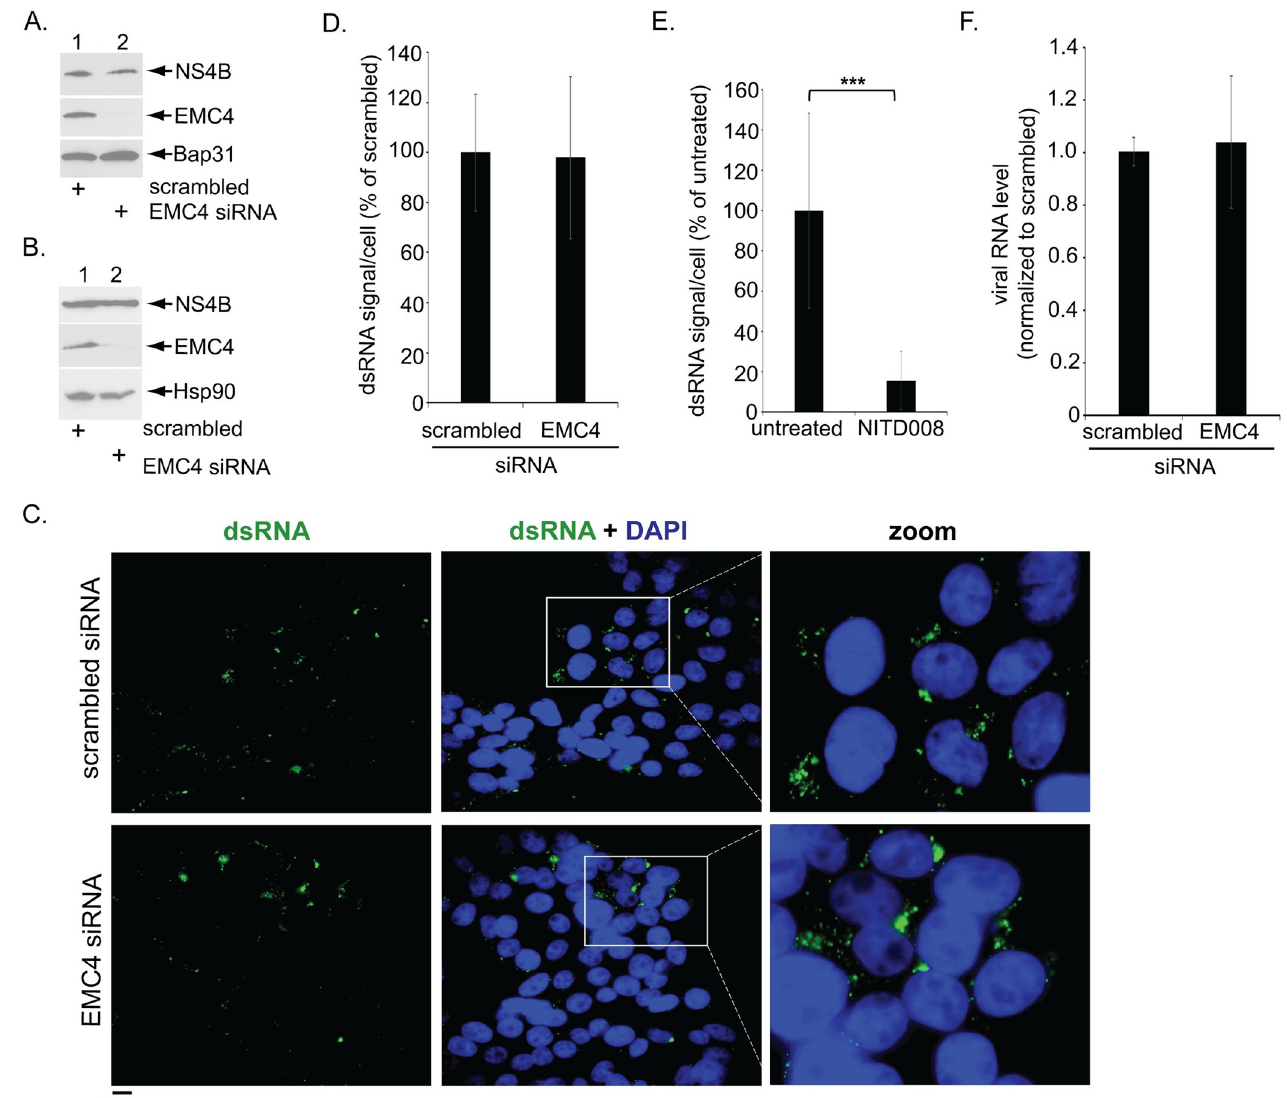
Fig 2. EMC4 does not promote ER-dependent biosynthesis of a DENV non-structural protein or viral replication. A. HEK 293T cells were transfected with the indicated siRNAs followed by transfection with the DENV NS4B mini-gene expressing plasmid. The cells were then lysed with 1% Triton X-100, and the resulting extract was subjected to SDS-PAGE and immunoblotting with the indicated antibodies. B. Huh 7.5.1 cells stably expressing DENV2 replicon were transfected with the indicated siRNAs and lysed with 1% Triton X-100, and the resulting extract was subjected to SDS-PAGE and immunoblotted with the indicated antibodies. C. Huh 7.5.1 cells stably expressing the DENV2 replicon were transfected with the indicated siRNAs, fixed, stained with the indicated antibody, and imaged under widefield epifluorescence microscope. Zoomed-in images of the white box regions are also shown. D. Quantification of dsRNA signal/cell from C. E. As in D, except cells were treated with or without 10uM NITD008. F. Huh 7.5.1 cells stably expressing the DENV2 replicon were transfected with the indicated siRNAs and the total RNA were extracted followed by RT-qPCR to monitor the viral RNA level (normalized to scrambled). ��� P �